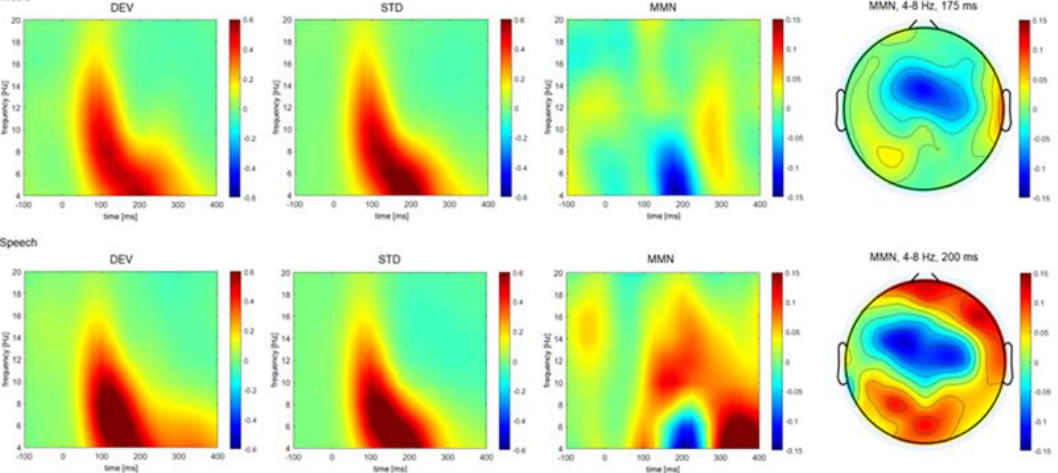
Figure 5. Grand average power temporal spectral evolution (TSE) elicited by standard and deviant stimuli, and the corresponding difference during the music oddball paradigm. ( A ) Time ‐ frequency plots for deviant (DEV), standard (STD) stimuli, and the corresponding different wave used to isolate the mismatch negativity (MMN). ( B ) Time ‐ frequency plot for the vowel stimuli.